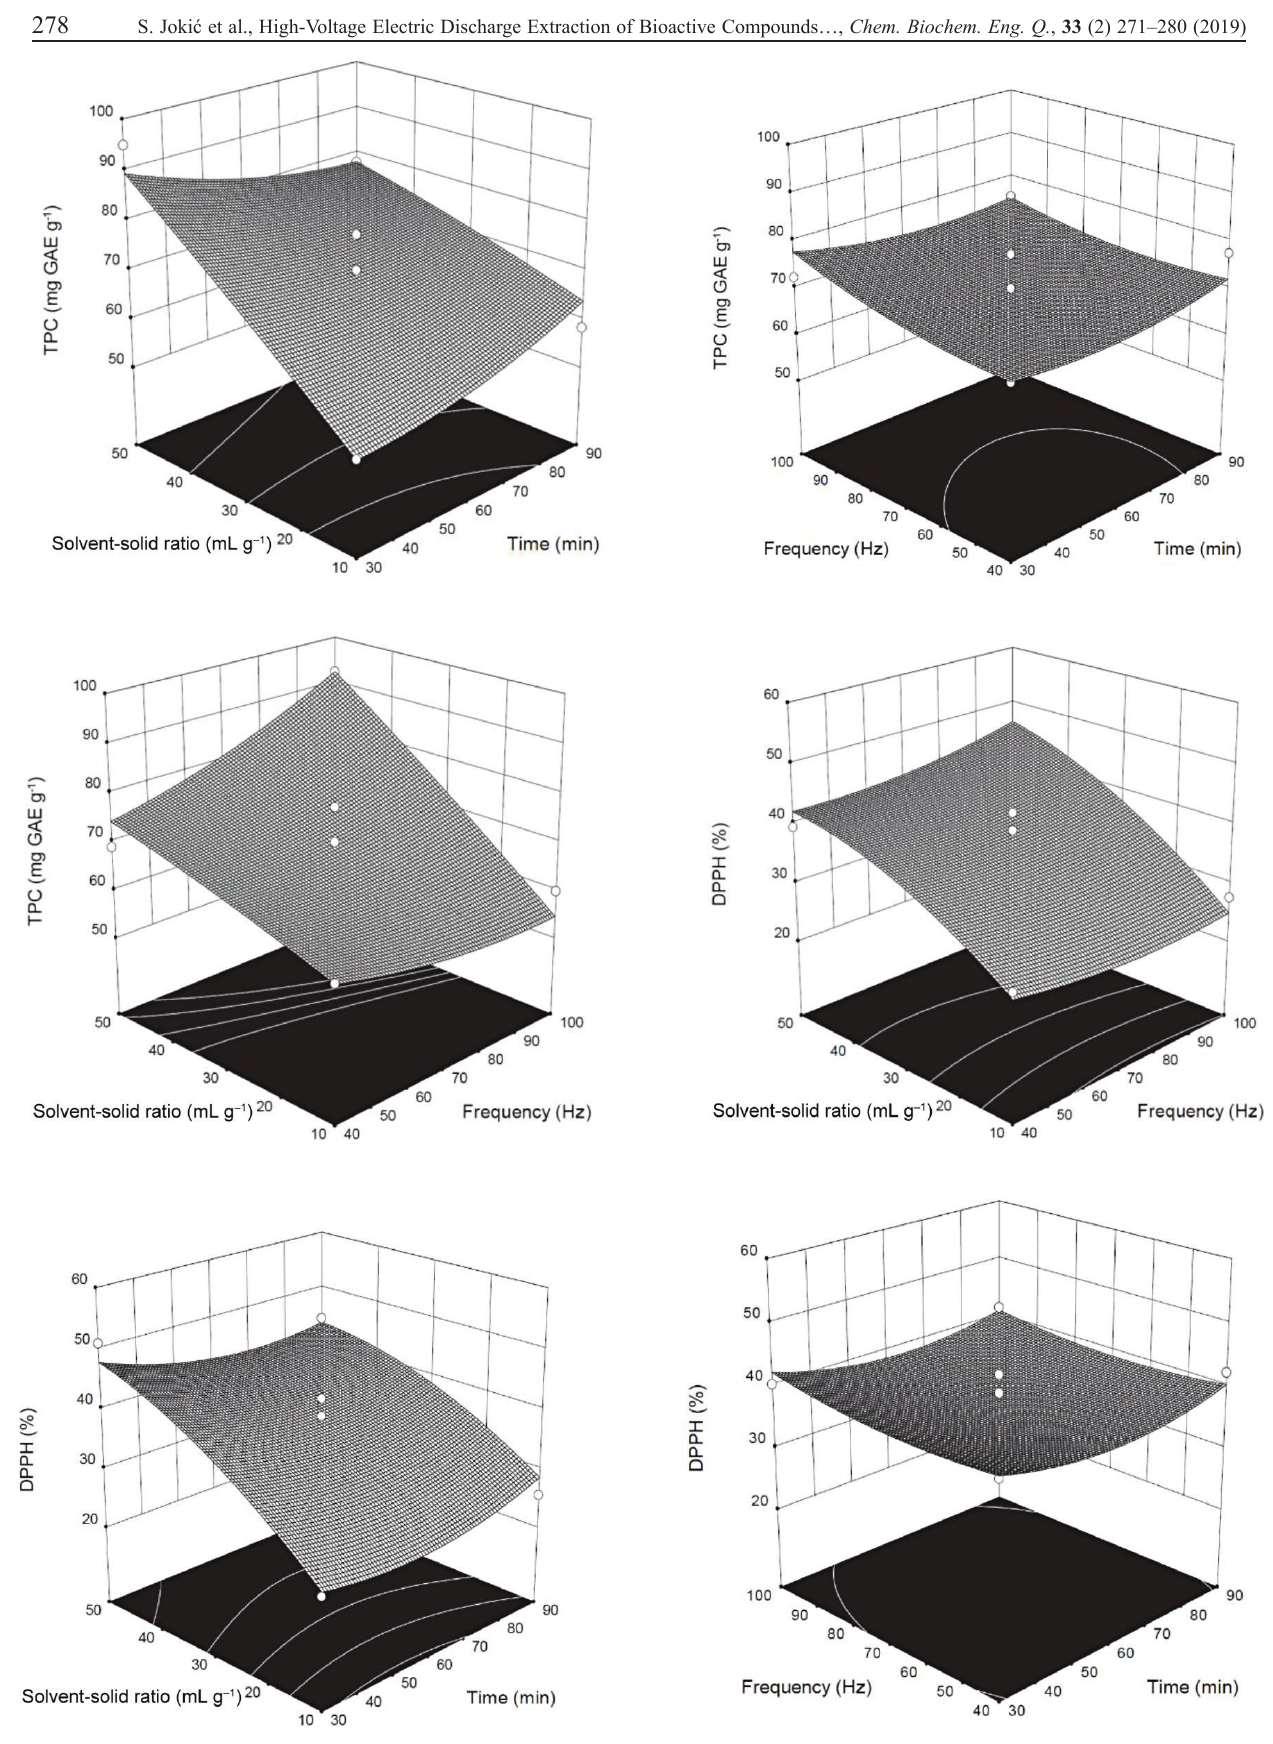
Fig. 2 – Response surface plots showing the effects of investigated variables on TPC and DPPH scavenging activity as a function of different process